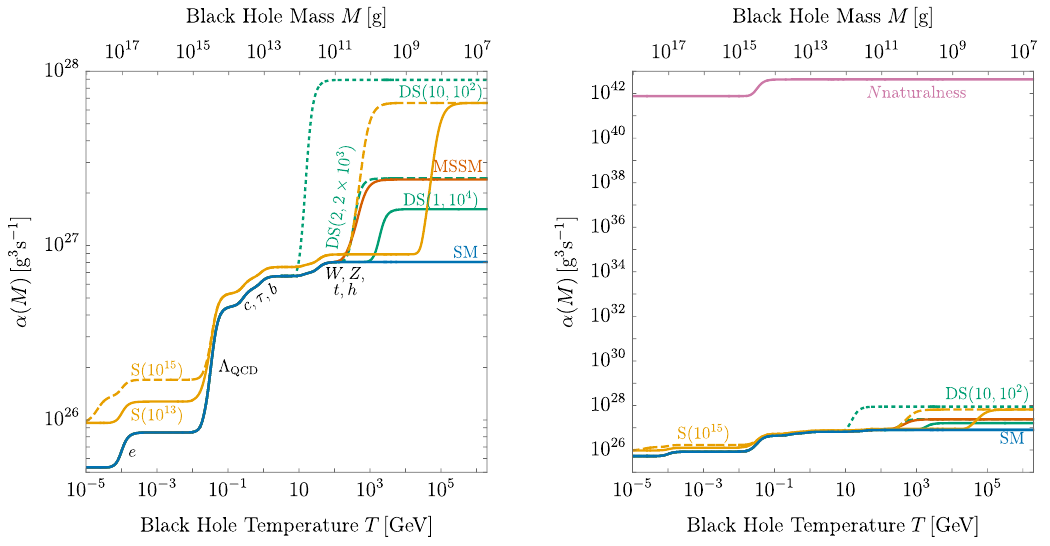
Figure 2 . The function α ( M ) which accounts for all directly emitted particle species, for our benchmark models excluding (left) and including (right) N